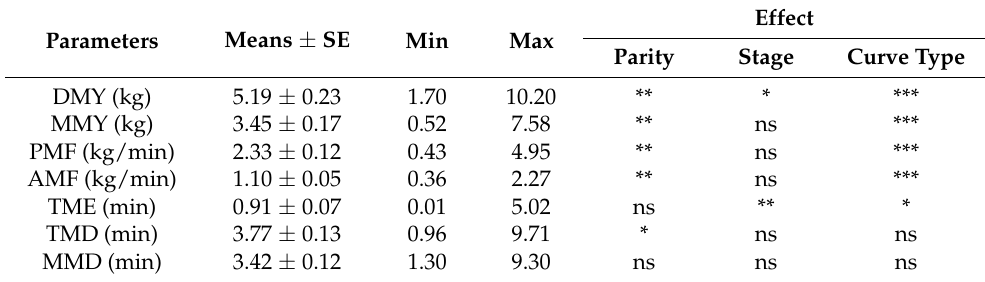
Table 2. Milk yield and milk flow parameters in dromedary camels and effect of lactation stage, parity and milk curve type in dromedary